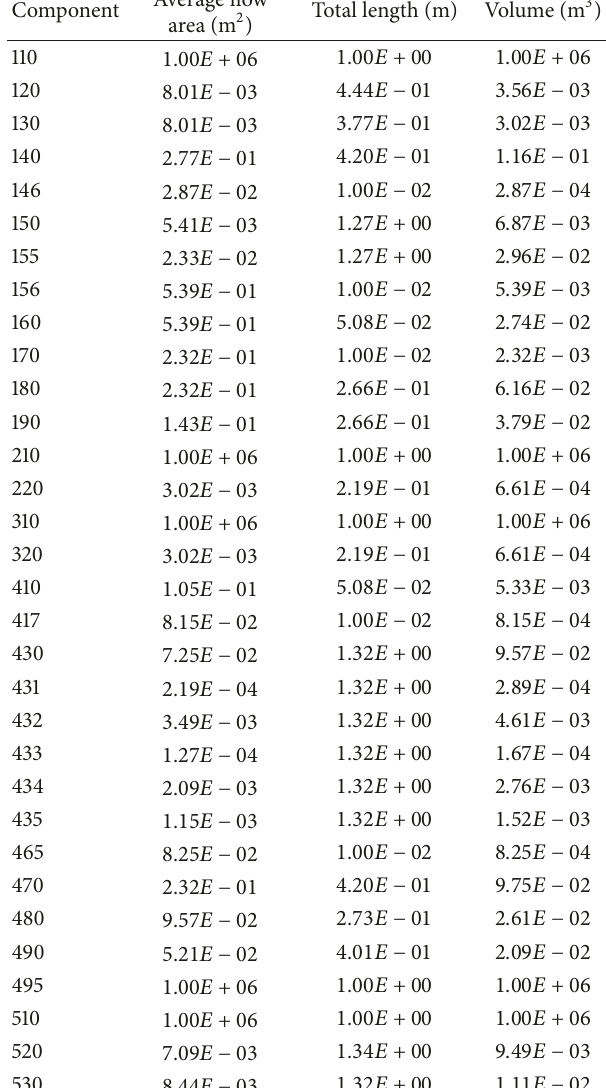
Table 4: Area weighted emissivity with various stages of corrosion. Λ 𝐴 c